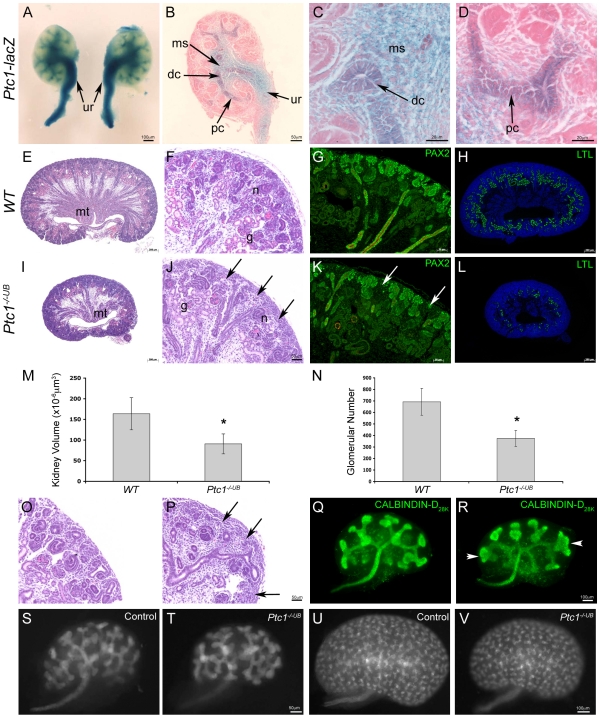
Renal hypoplasia in mice with Ptc1-deficiency in the ureteric cell lineage.(A–D) In Ptc1 mutant kidneys (Ptc1−/−
UB), Ptc1-lacZ expression is maintained in the cells surrounding the presumptive ureter (ur) and medullary stroma (ms). (A–C) HH signaling activity is upregulated in the epithelium of the presumptive ureter and distal collecting ducts (dc). (D) Ectopic HH signaling activity is observed in the proximal collecting ducts (pc) and weakly in ureteric bud tips. (E–L) Histological and immunofluorescence analysis of WT and Ptc1−/−UB kidneys at E18.5. Ptc1-deficient mice exhibit small kidneys, reduced density of medullary epithelial tubules (mt) and a paucity of mature glomeruli (g) and nephrogenic intermediate structures (n) and sparsity of the nephrogenic zone (arrows). (G,K) PAX2 (green) positive nephrogenic structures are reduced in the Ptc1−/−UB kidneys. (H,L) LTL (green) positive proximal tubules are markedly reduced in Ptc1−/−UB kidneys. (M) Kidney volume in Ptc1−/−UB mutants is reduced by 45% in comparison to WT littermates (p<0.01). (N) Ptc1−/−UB kidneys demonstrate a 45% reduction in mature glomerular number compared to WT littermates (p<0.01). (O,P) Histological analysis also revealed a sparsity of the nephrogenic zone (arrows) and reduction in the number of nephrogenic structures in Ptc1−/−UB compared to WT kidneys at E15.5. (Q,R) Analysis of ureteric branching morphogenesis in WT and Ptc1−/−UB kidneys at E12.5. The number of ureteric branches was comparable between WT and Ptc1−/−UB kidneys. However, Ptc1−/−UB kidneys exhibited abnormal ureteric tip morphology (arrowhead). (S–V) Whole mount GFP immunofluorescence of control and mutant kidneys. Kidney size and branching is mildly reduced at E13.5 (S,T) and is more pronounced at E15.5 (U,V).